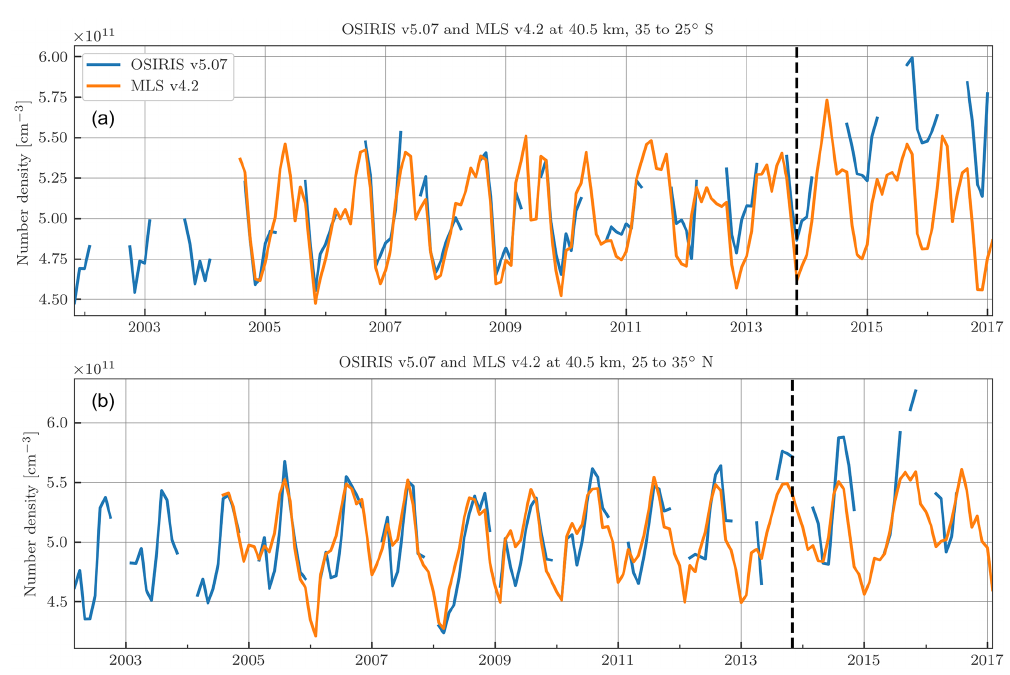
Figure 1. OSIRIS version 5.07 and MLS version 4.2 ozone density at 40.5km and 35 to 25 ◦ S (a) and 25 to 35 ◦ N (b) . The end of the OSIRIS data set used in the Bourassa et al. (2014) trend study is marked with the vertical black dashed